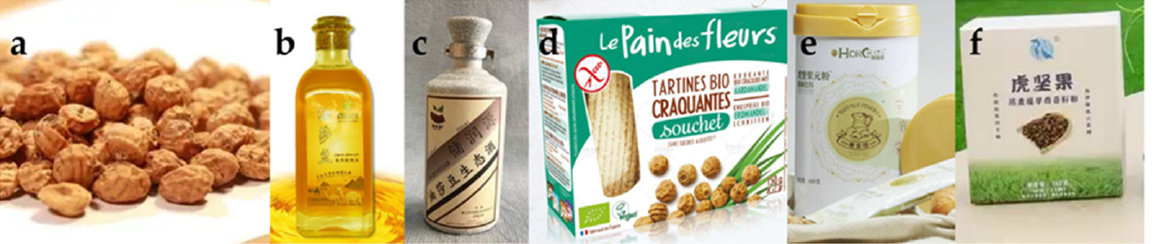
Figure 4. Tiger nut tuber and its products (( a ) tuber; ( b ) edible oil; ( c ) liquor; ( d ) crunchy bio toast; ( e ) solid powder drink; ( f ) meal replacement powder).